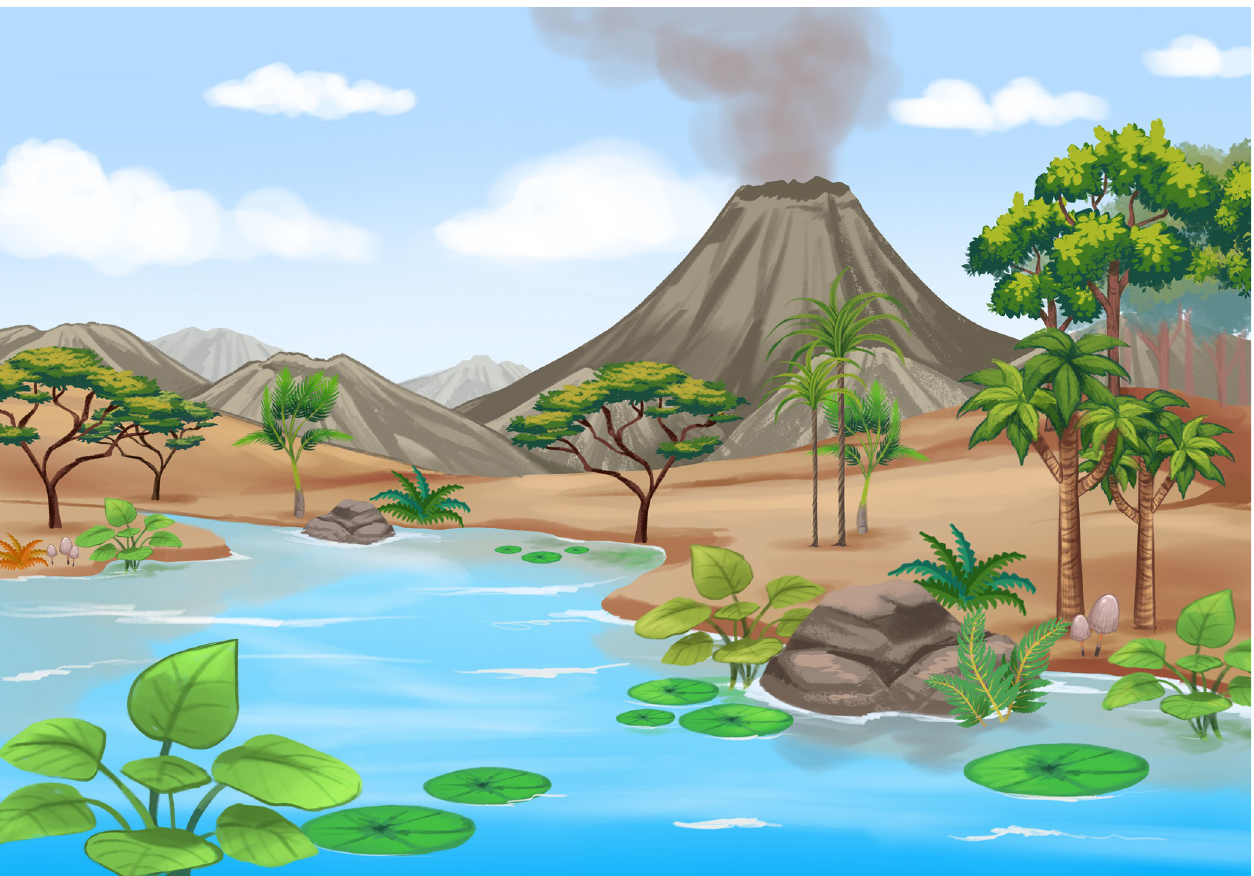
Fig 8. Reconstruction of southern Central Andean landscapes during the Eocene. The nearest living representatives of the discovered fossils indicate the presence of trees and shrubs nearby a vegetated pond with ferns and floating plants.